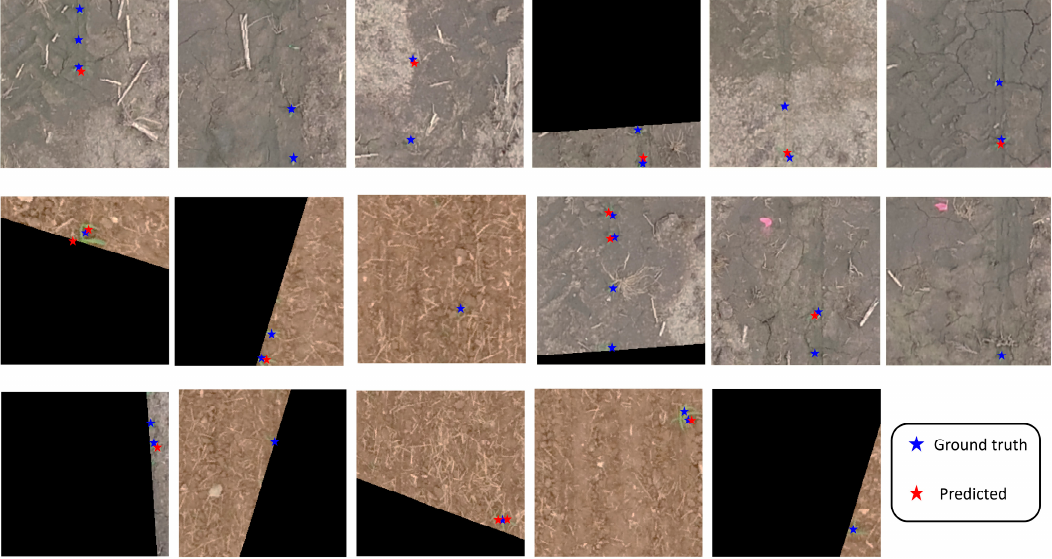
Figure 15. Extracted patches with normalized counting errors higher than 0.5.